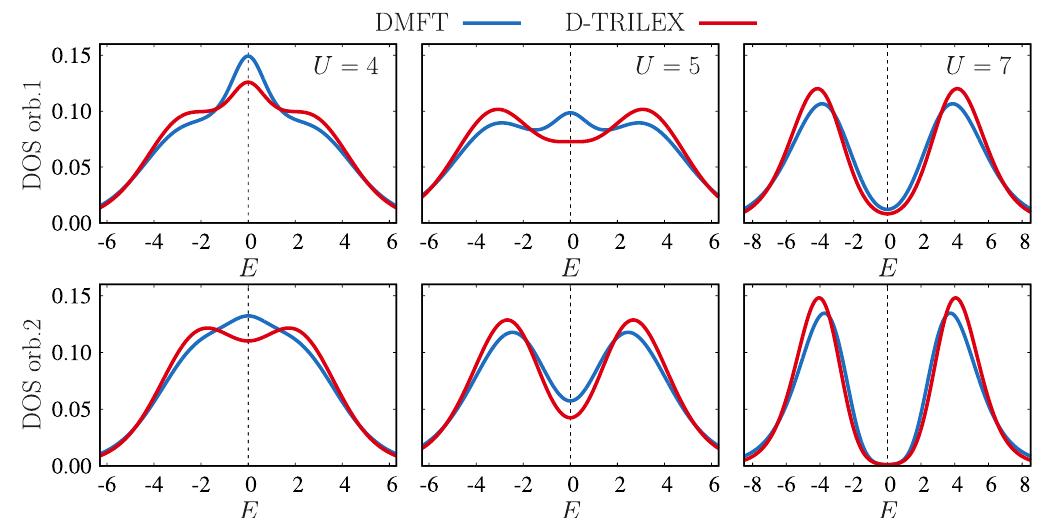
Figure 8: DOS for the two-orbital Hubbard-Kanamori model obtained using DMFT (blue line) and D-TRILEX (red line). The value of the interaction U is indicated for each column. The other parameters for the interaction are U (cid:48) = U / 2 and J = U / 4. The top and bottom rows display results for the orbitals l = 1 and l = 2, respectively. The half-bandwithds for these orbitals are D